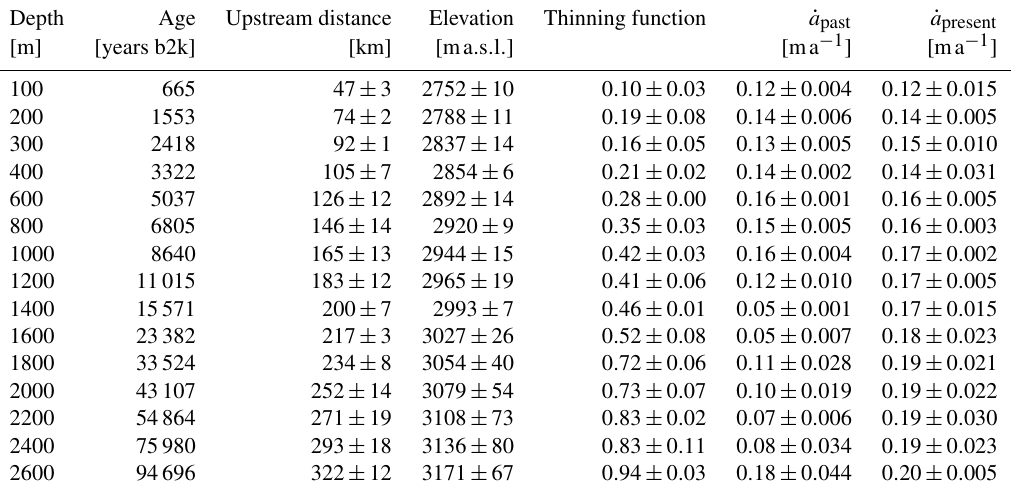
Table 5. Essential quantities for upstream corrections for selected depths of the EastGRIP ice core. The upstream distance, elevation and past accumulation rates ˙ a past describe the characteristics of the source location and the conditions during ice deposition. ˙ a present represents the corresponding present-day accumulation rates at the source location. All quantities are averages over the three flow lines, and the uncertainties represent the maximum deviation from the